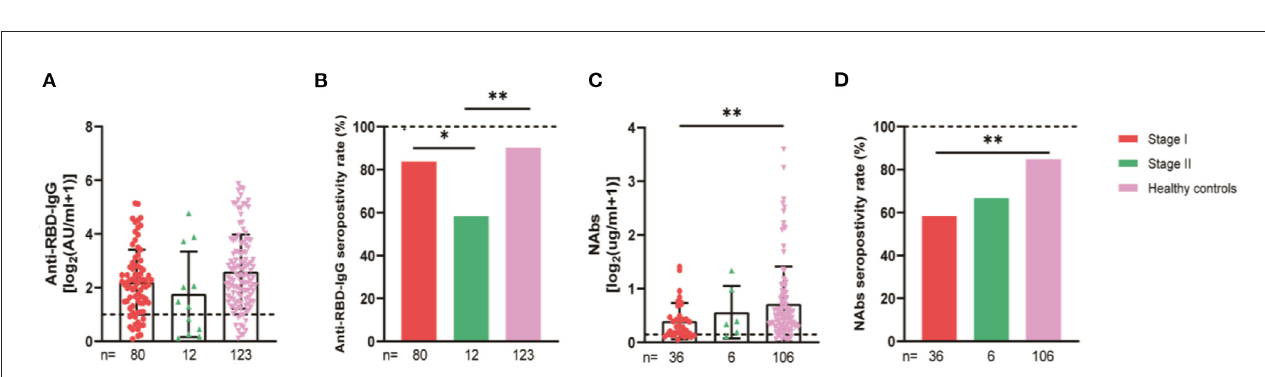
FIGURE10 Antibody response to SARS-CoV-2 vaccine in thyroid cancer patients at the AJCC stages. Subgroup analysis of the titers and seropositivity rate of anti-receptor binding domain (RBD)-IgG (A, B) and NAbs (C, D) in participants according to different treatments. The horizontal dotted lines represent the limit of detection. The error bars represent the median (IQR) (* P < 0.05, ** P < 0.01). NAbs, neutralizing antibodies; IQR, interquartile range; RBD, receptor binding domain.